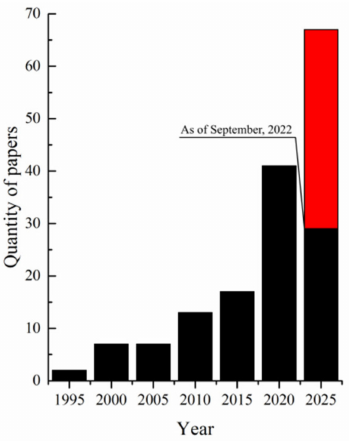
Figure 1. Number of results for “UHMWPE membrane” in quotation marks in Google Scholar. UHMWPE is ultra high molecular weight polyethylene. The horizontal axis represents the years of completion of the five-year interval for calculating the results (1991–1995; 1996–2000; 2001–2005, etc.). The red part shows the expected number of papers by the end of